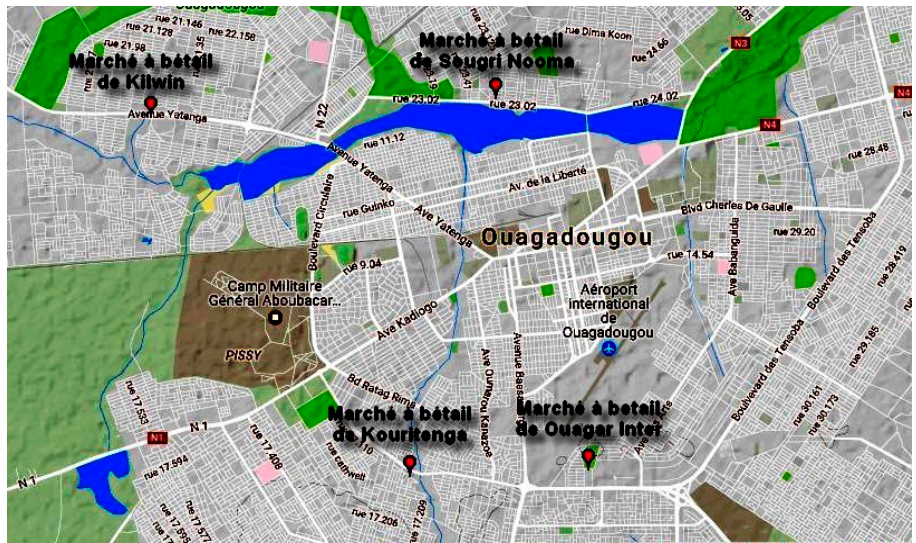
Figure 1. Map of Ouagadougou with the sampling sites. Source: Google Map.